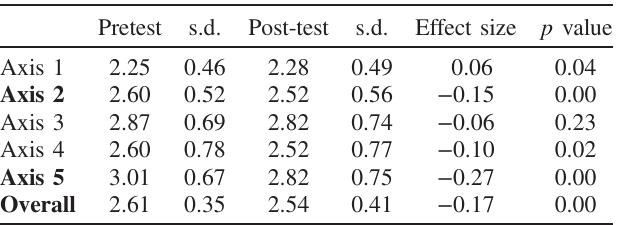
TABLE II. Baseline pretest and post-test results by EBAPS axis. a Pretest